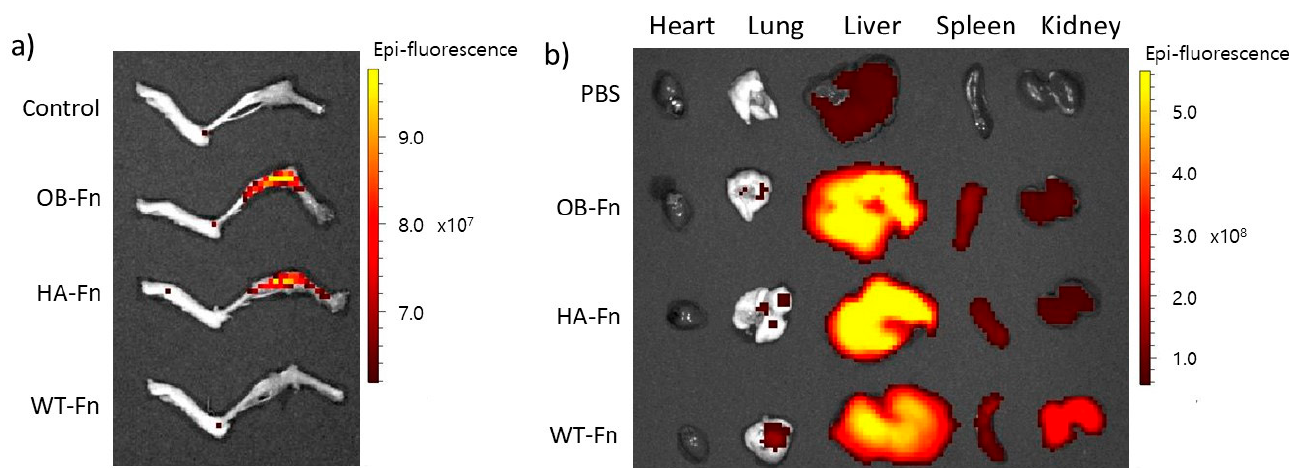
Figure 5. Bone-specific binding of ferritin nanoparticles. Cy5-labeled OB-Fn, HA-Fn, and WT-Fn were administered at a dose of 10 mg/kg and the images of ( a ) lower limbs and ( b ) dissected organs were acquired after 24 h. Fluorescent signals were only observed in the lower limbs of mice treated with OB-Fn and HA-Fn.